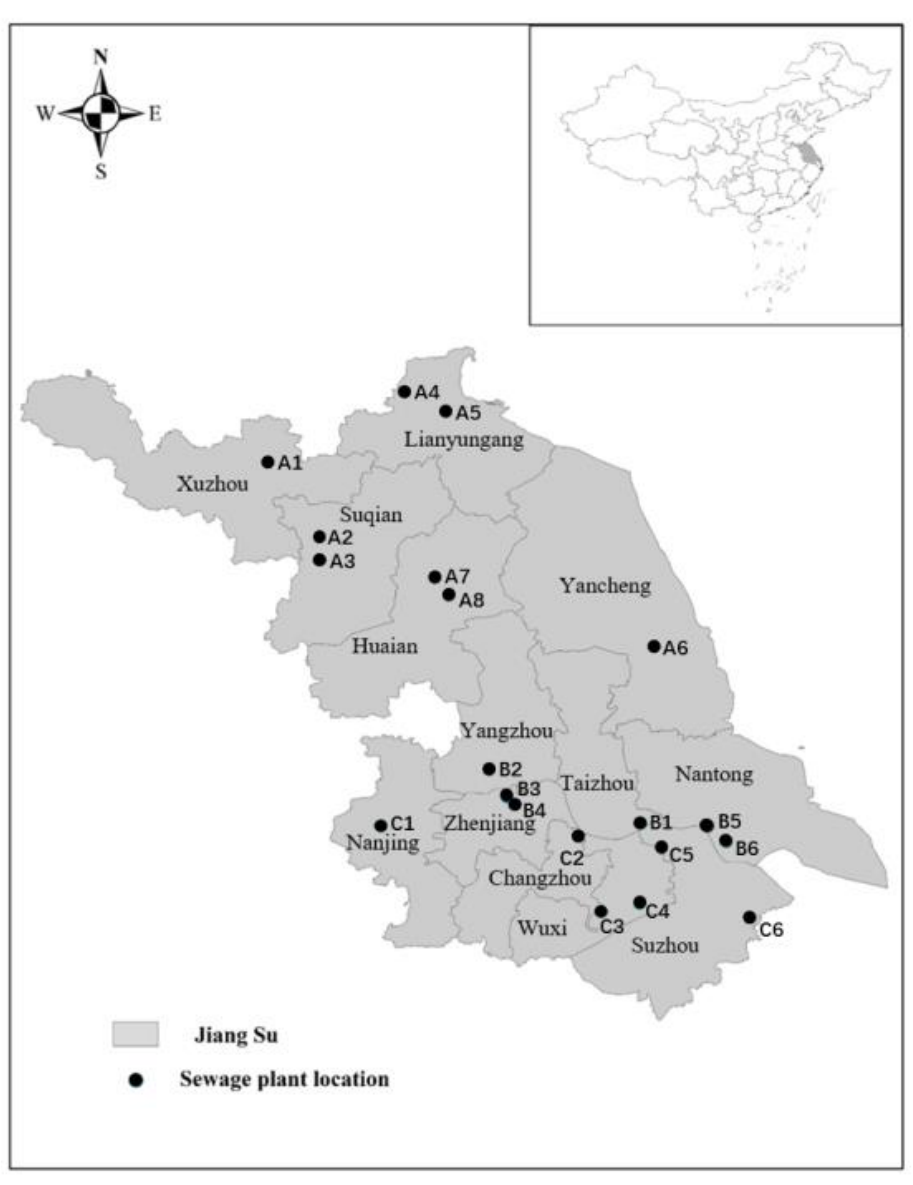
Figure 2. Distribution of 20 sewage treatment plants in Jiangsu.